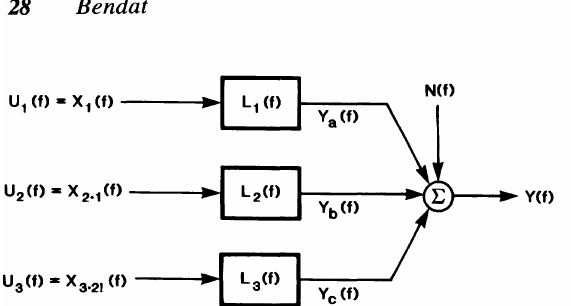
FIGURE 10 Revised three-input I single-output linear model equivalent to Fig. 9 where the inputs are mutu ally